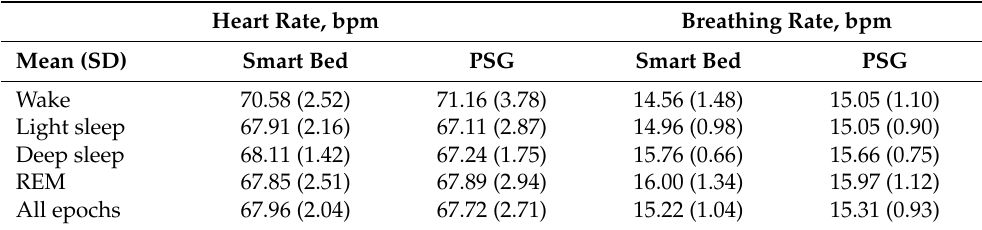
Table A1. Mean epoch-by-epoch HR and BR during different sleep stages. The standard deviation of instantaneous HR and BR were computed on a 15 min, centered, moving window and are grouped and averaged based on PSG sleep stages, representing the 15 min HR and BR variability.